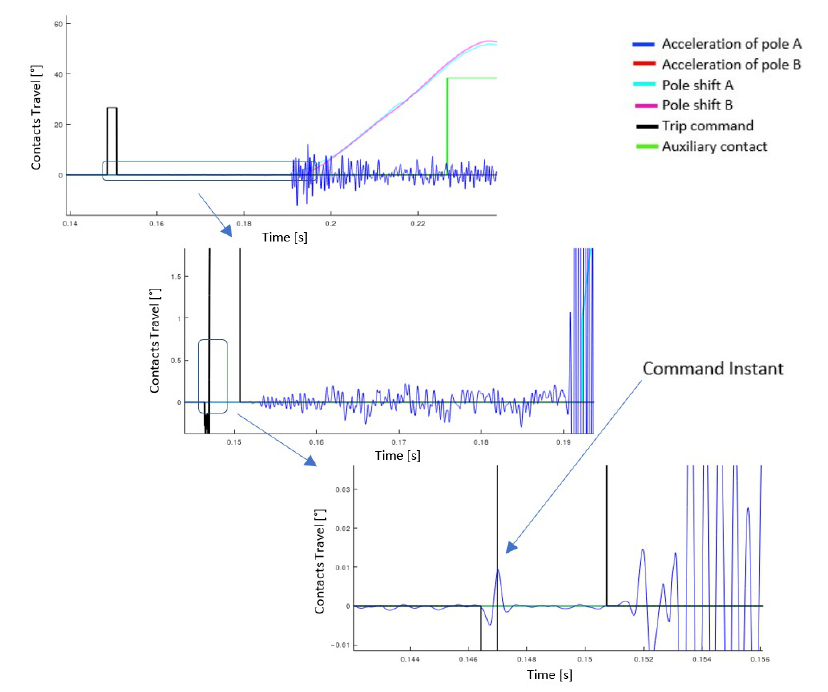
Figure 8. Instant of the closing command, highlighting the difference between the acceleration signals of poles A and B.